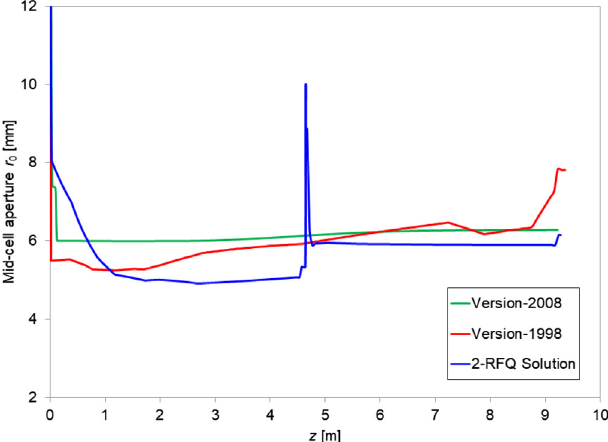
FIG. 3. Evolution of the midcell aperture along the accelerating channel (compared with the Version-1998 and Version-2008 RFQs).